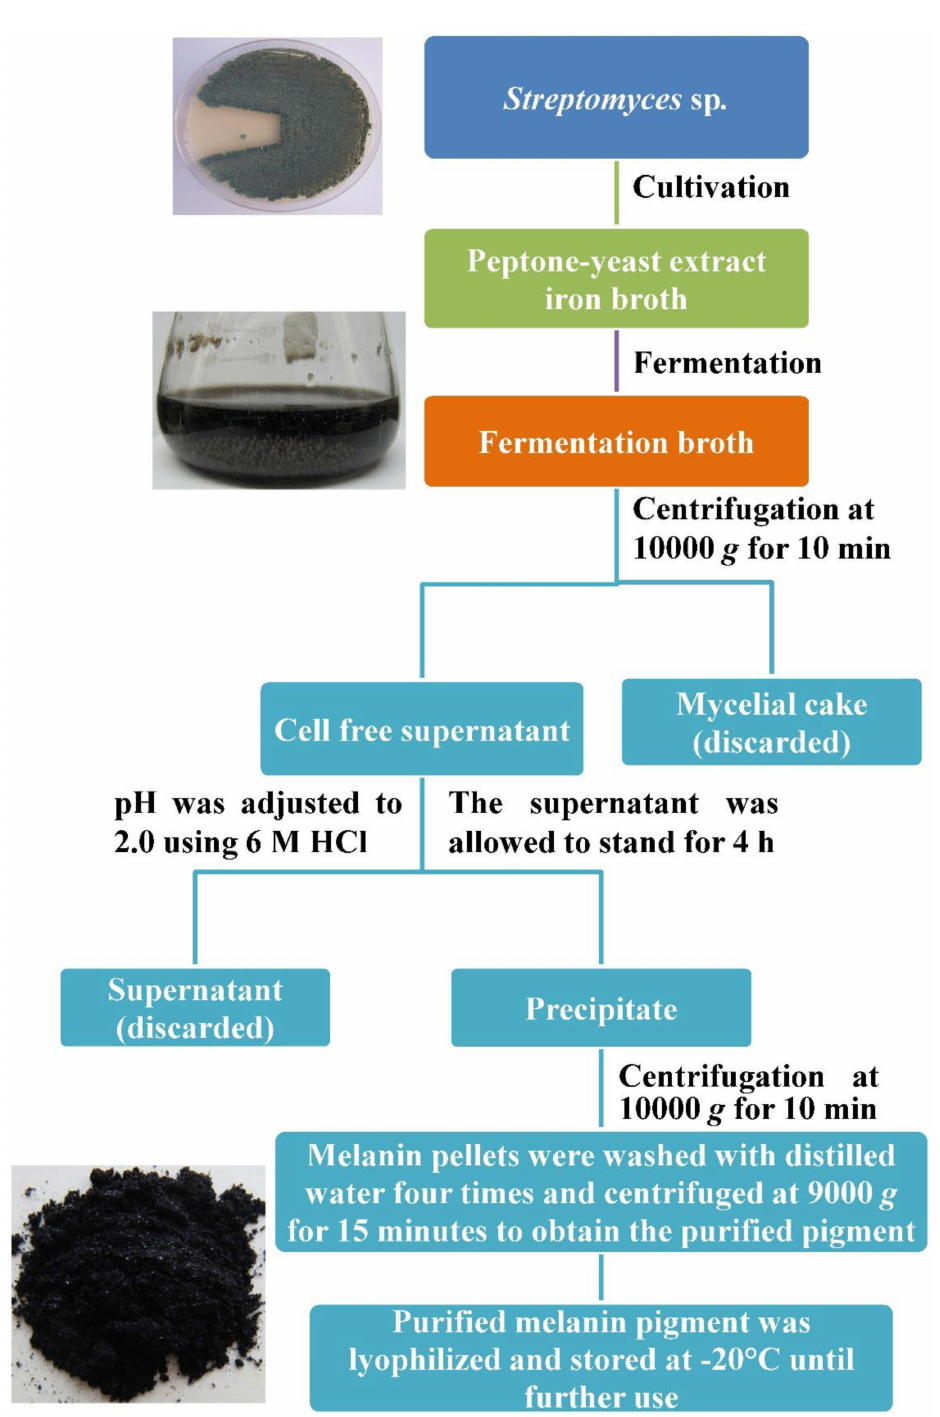
Figure 4. The general procedure of microbial melanin production. The graph was designed based on the data extracted from a previous